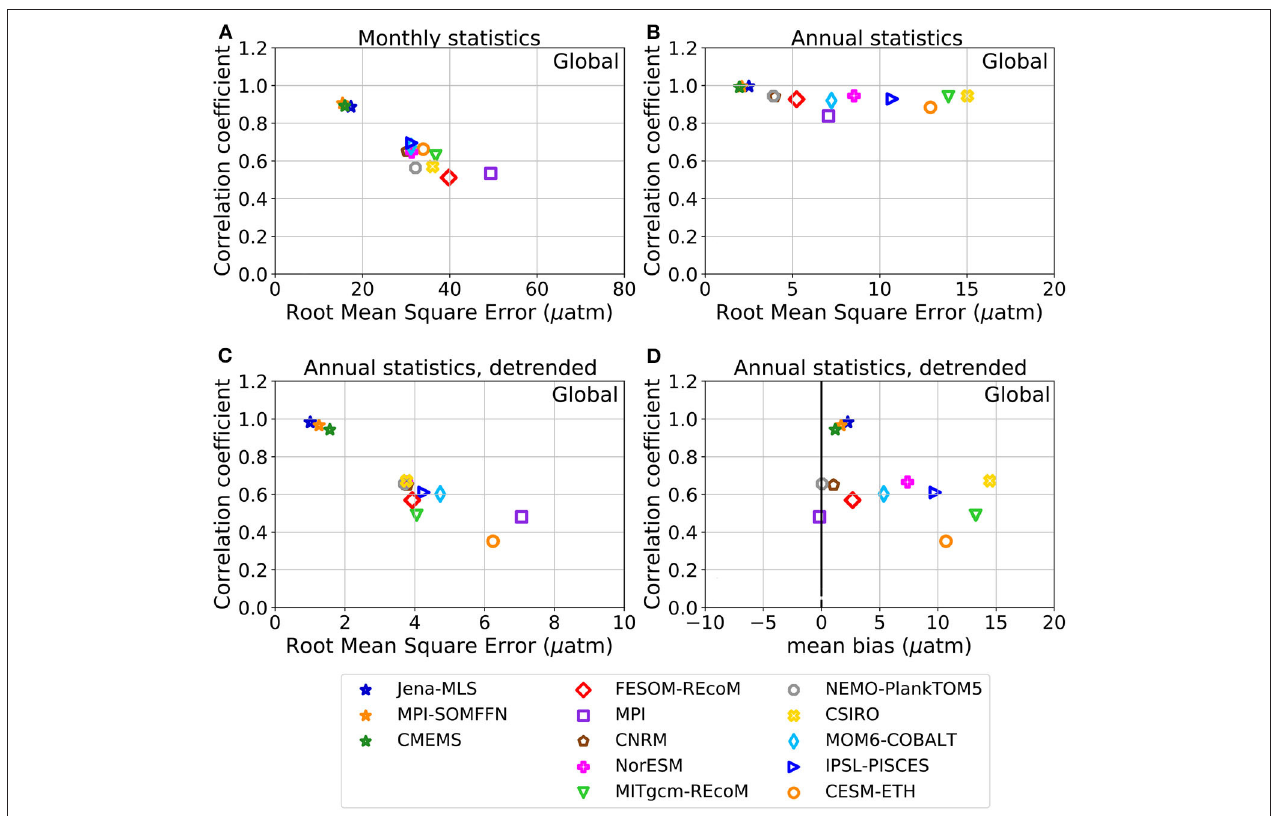
FIGURE 9 | Mismatch of simulated or mapped p CO 2 and observed sea surface p CO 2 for the period 1992–2018 on different time-scales: (A) monthly, (B) annual + trend as derived from annual statistics, (C) multi-year variability as derived from detrended annual statistics, (D) long term mean. (A–C) Display the mismatch as RMSE and correlation coefficient. In (D) the mean bias is plotted against the correlation coefficient. Global figures are shown here, regional figures (north, tropics, south) are displayed in the Supplementary Material . Note the different scales on the